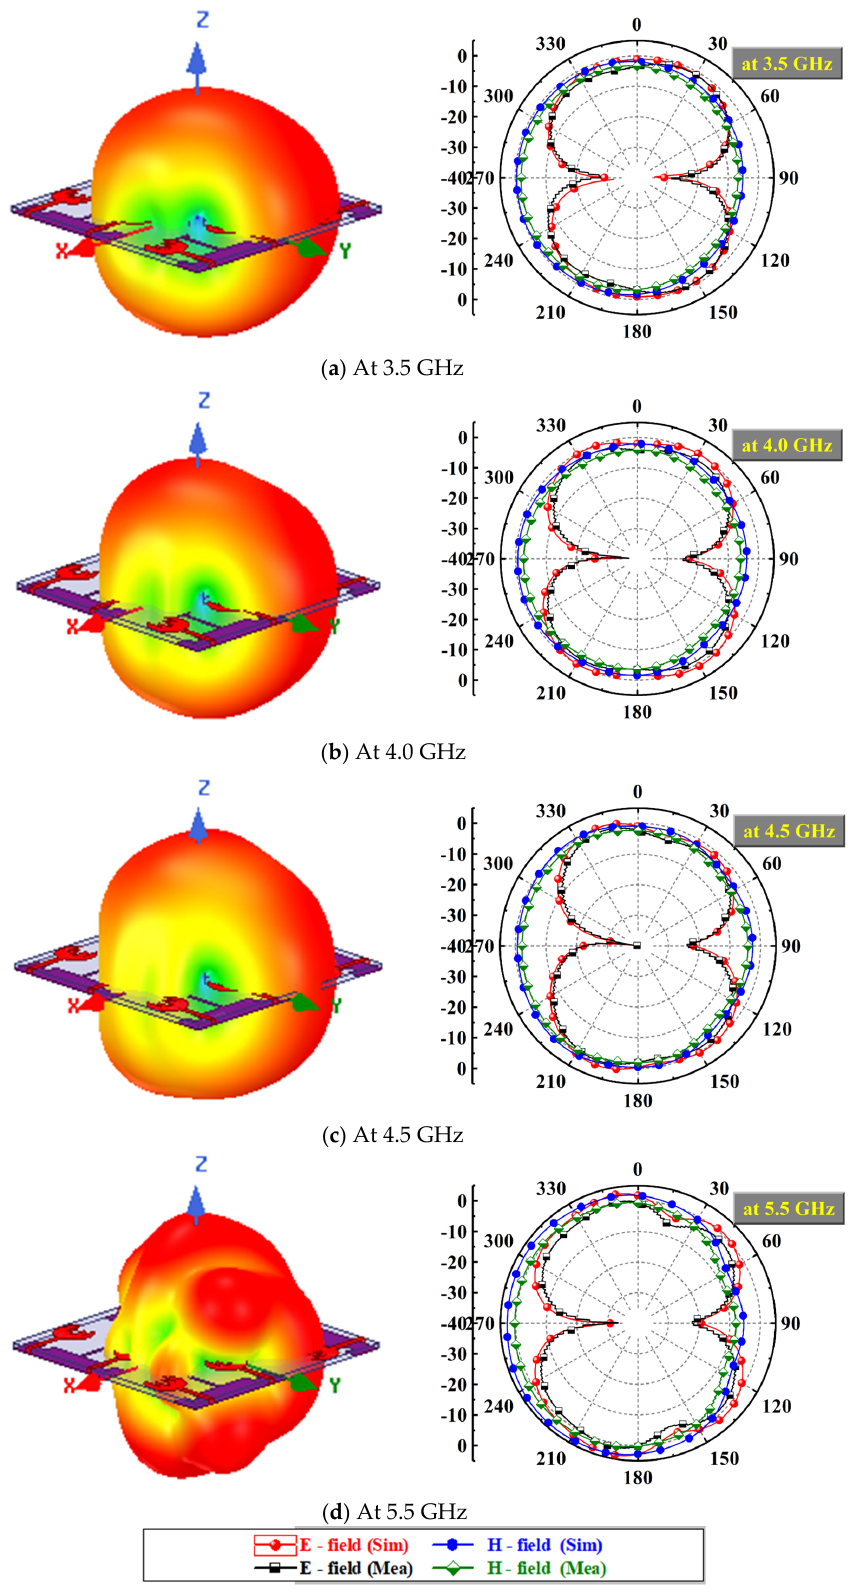
Figure 14. ( a – d ) Radiation performance response in working band frequencies.